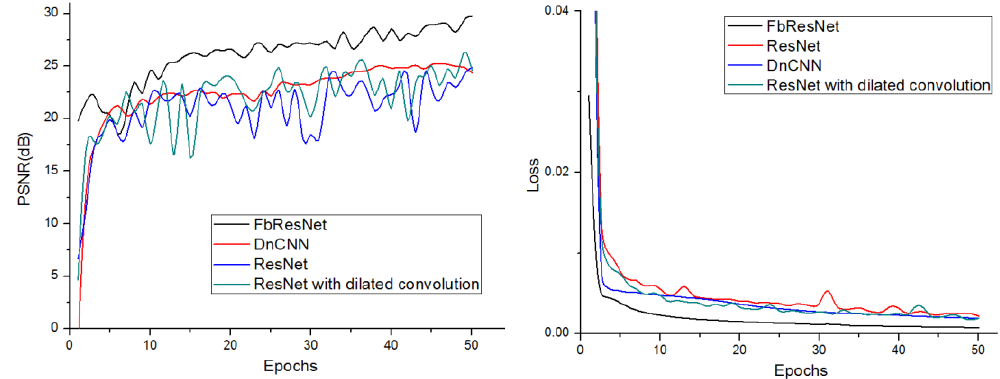
Figure 6. Peak signal-to-noise ratio (PSNR) and loss function for motion deblurring.